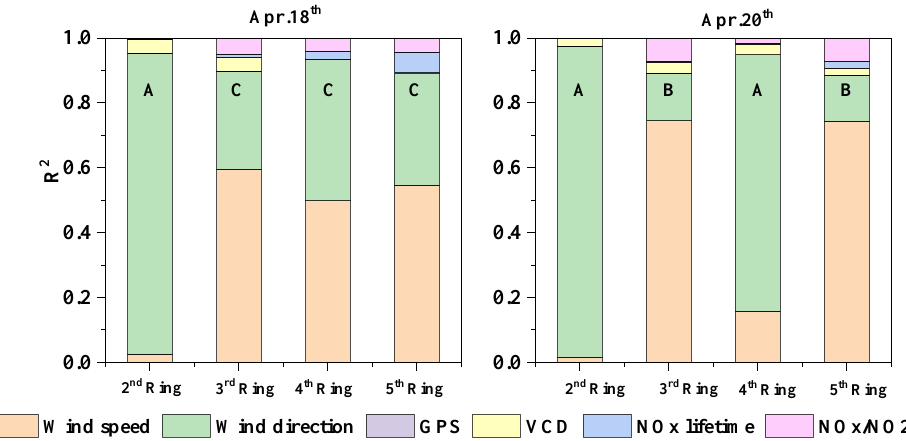
Figure 9. The R 2 of the ring roads measured on April 18th and 20th. Group A’s main error source is the wind direction uncertainty. Group B’s main error source is the wind speed uncertainty. Group C’s main error is both the wind direction uncertainty and the wind speed uncertainty.